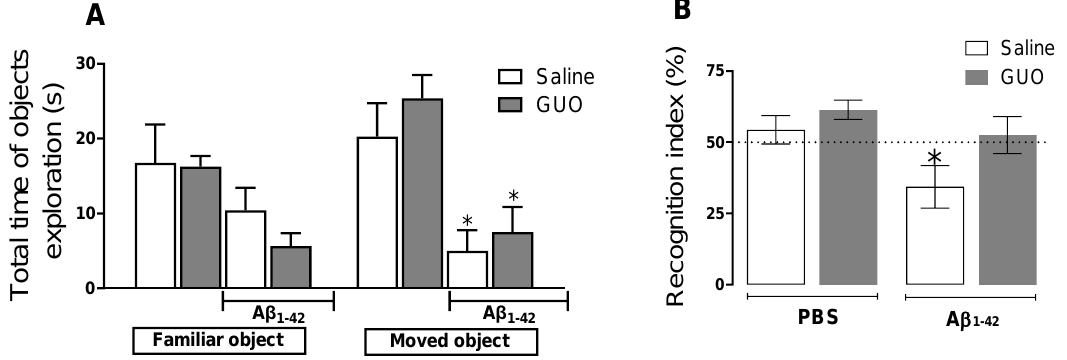
Figure 5. Guanosine prevents A β 1–42 -induced short-term spatial memory impairment in mice. Mice subjected to A β 1–42 infusion (400 pmol/site) received guanosine (GUO, 8 mg/kg, i.p.) for nine days. On the tenth day, mice were subjected to the object location test and the total time of familiar and moved objects exploration were assessed ( A ) * p ≤ 0.05 compared with the vehicle- and GUO- treated group. The recognition index of location was calculated as the percentage of time exploring the moved object in relation to the time exploring the familiar object and * p < 0.05 compared to the hypothetical 50 % (dashed line) of random exploration ( B ). Values expressed as mean + S.E.M (n = 8–10). (Two-way ANOVA followed by Tukey’s